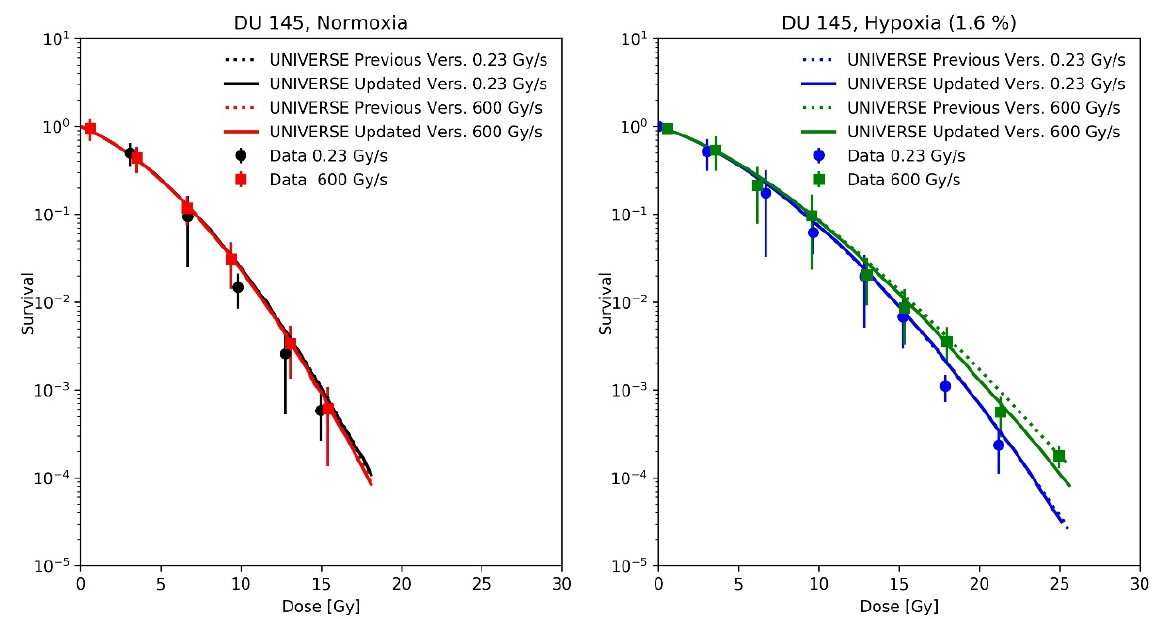
Figure 5. Measured cell survival of DU145 cells taken from Adrian et al. [21] after irradiation with 10 MeV electrons at conventional dose-rate (circles, 0.23 Gy/s) and uHDR (squares, 3 Gy per pulse and 200 Hz = 600 Gy/s) under normoxic, ( left panel ) and hypoxic (1.6% O 2 , right panel ) atmosphere with predictions based on previous implementation of UNIVERSE (dotted lines) and updated UNIVERSE including the extensions presented in this study (solid lines).